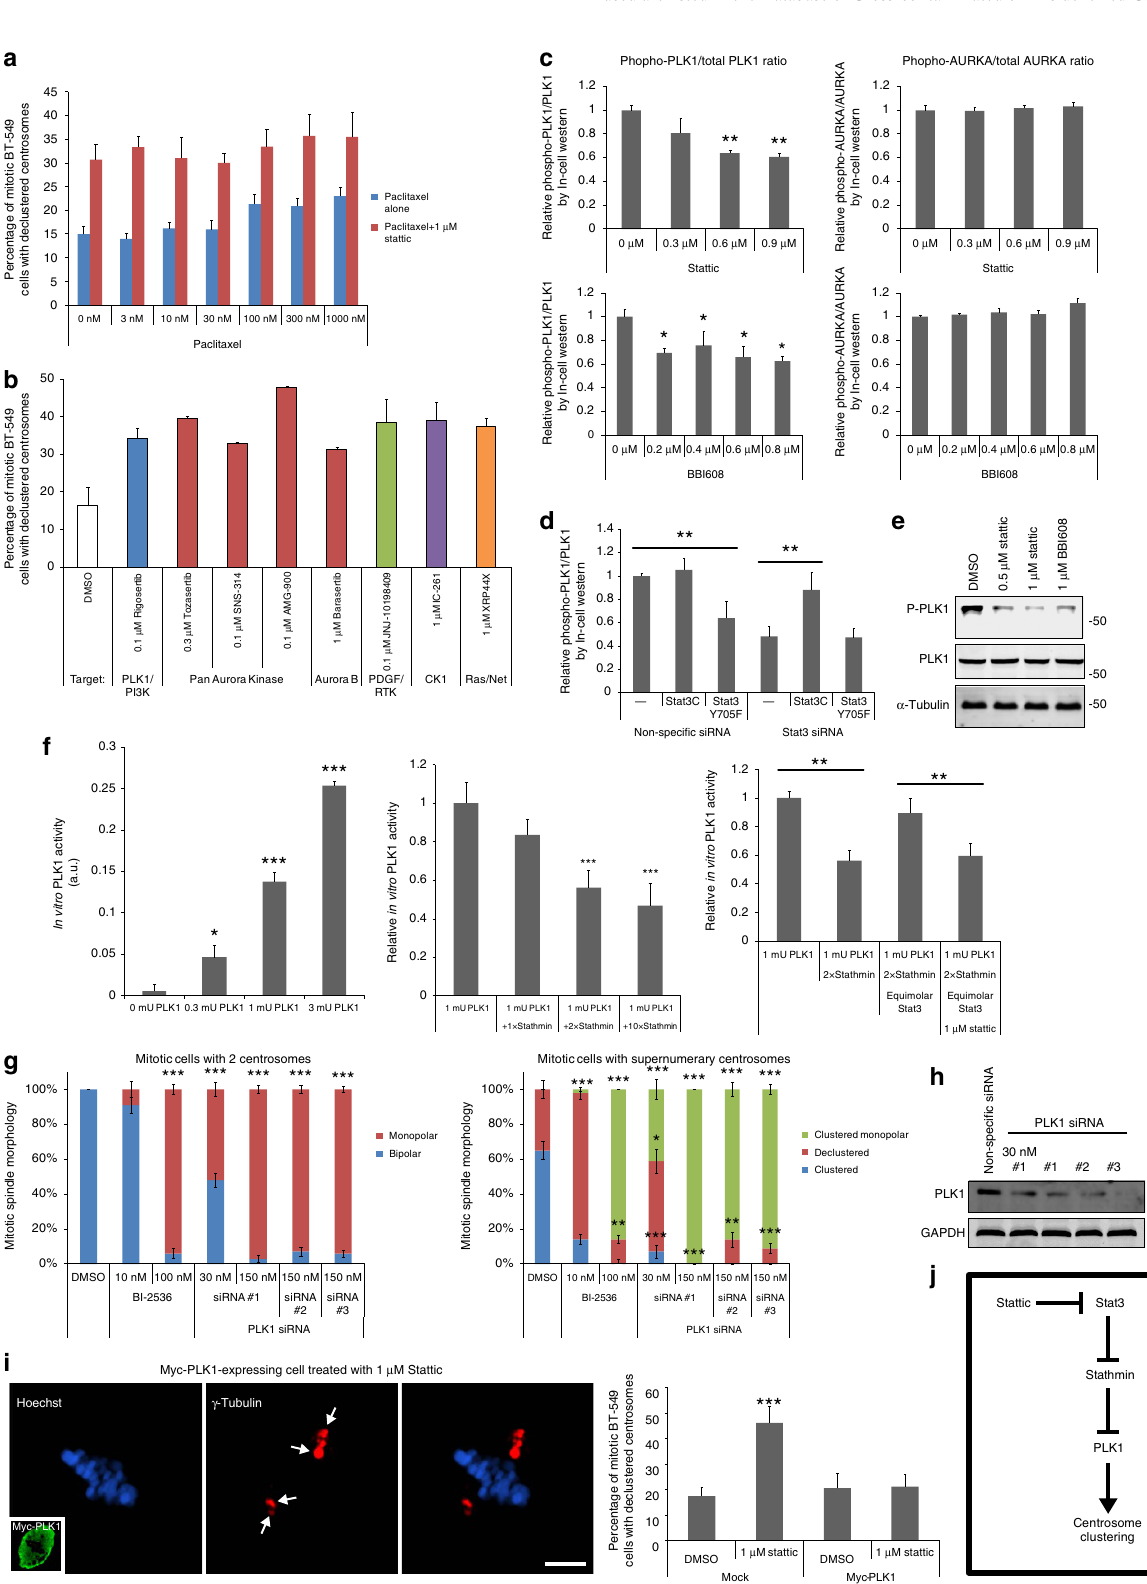
Methods Cell culture . All cell lines were from American Type Culture Collection except the MCF10-A (Sigma Aldrich, St Louis, MO, USA), OPM-2 (DSMZ, Braunschweig, Germany), the normal primary human bone marrow cells (Stem Cell Technologies, Vancouver, Canada) and the primary HMECs (see below). None of the cell lines used are listed in the Database of Cross-contaminated or Misidentified Cell Lines 55